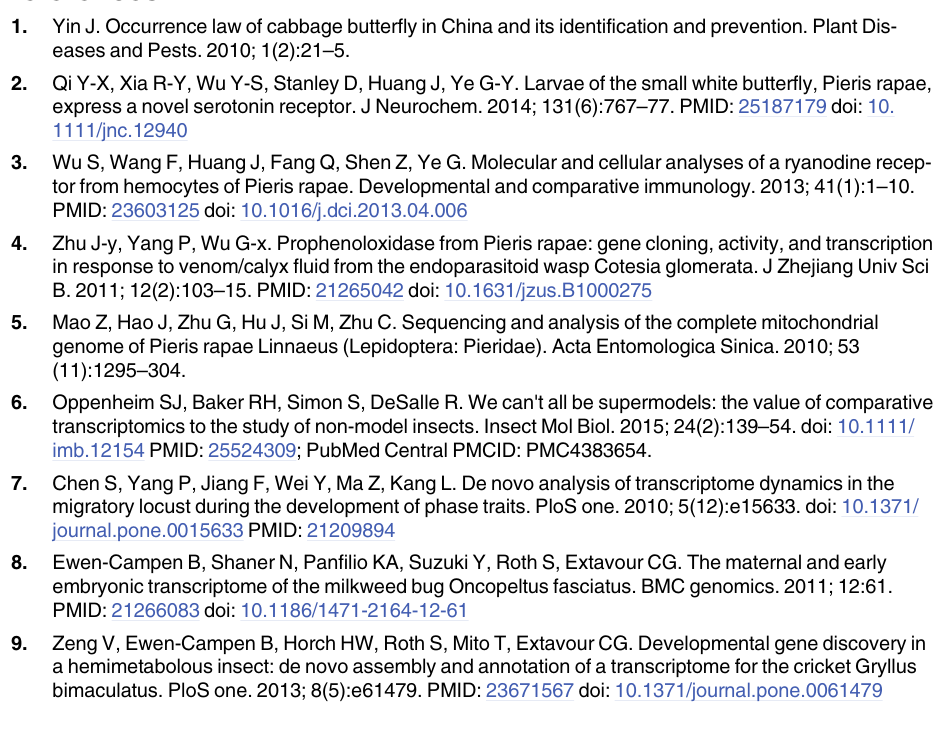
S2 Table. The Pieris rapae transcriptome involved in KEGG pathways. Partial nodes genes were listed in Table 2. S3 Table. Unigenes hits by key innate immunity related genes involved in Toll and IMD pathways as well as Pattern Recognition Receptors in Pieris rapae . S4 Table. List of the stage specific genes expressed during development. S5 Table. Primers of Hsp genes used for Real-time